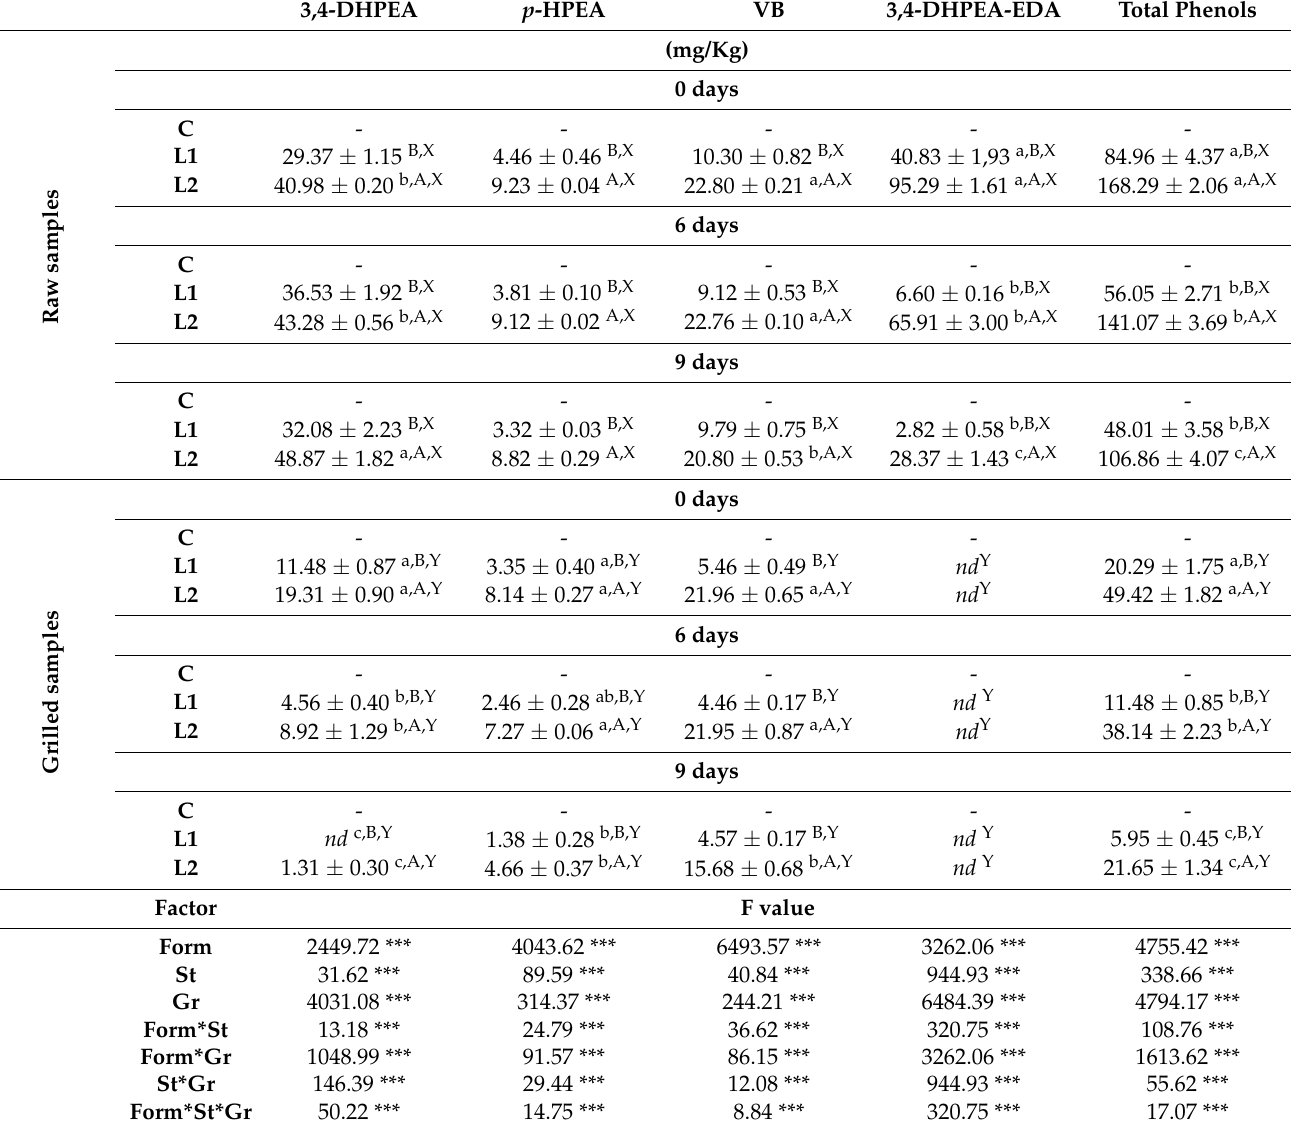
Table 2. Evolution of phenolic compounds of raw and grilled hamburger samples after 0, 6 and 9 days of storage. C, Control (minced beef meat + maltodextrine + starter cultures); L1, minced beef meat + starter cultures + 87.5 mg phenols/kg of meat; L2, minced beef meat + starter cultures + 175 mg phenols/kg of